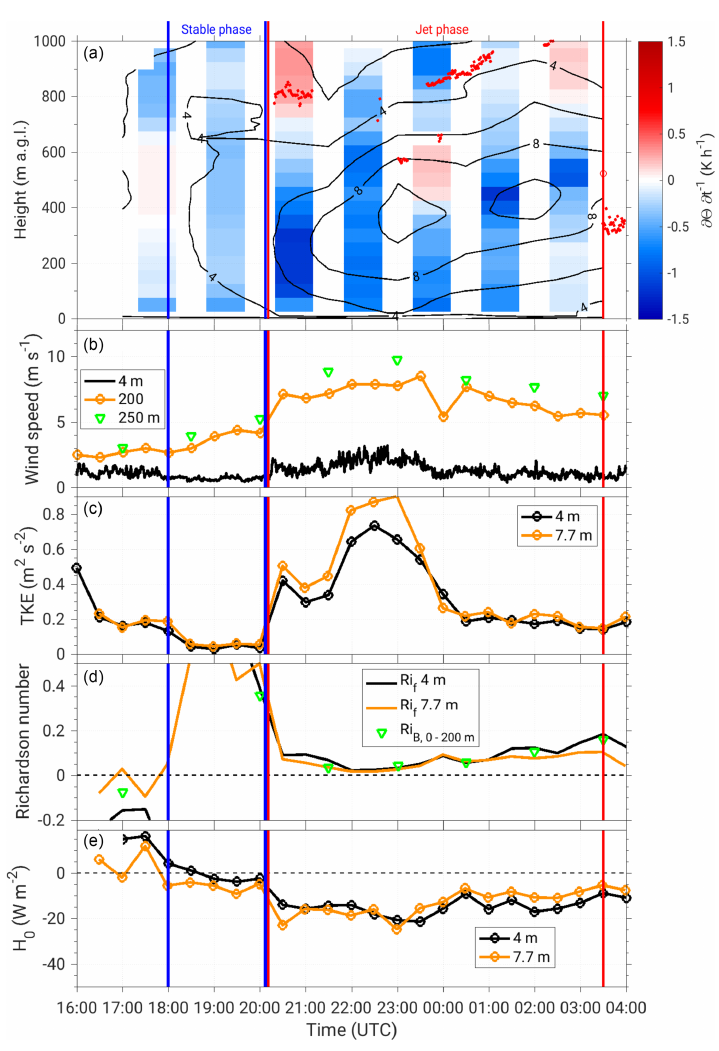
Figure 10. Time–height plot of potential temperature tendency (color coded) and horizontal wind speed (contours) from radiosondes (a) ; time series of horizontal wind speed from near-surface measurements at 4ma.g.l., Doppler lidar at 200ma.g.l. and radiosondes at 250ma.g.l. (b) ; turbulent kinetic energy, TKE (c) ; flux-Richardson number, Ri f , and bulk-Richardson number between the surface and 200ma.g.l., Ri B , 0 − 200m (d) ; and surface sensible heat flux, H 0 (e) for IOP 15. TKE, Ri f and H 0 are measured at 4 and 7.7ma.g.l. Blue and red vertical lines indicate the stable phase and jet phase, respectively. In (a) , each bar represents a potential temperature profile calculated and centered between consecutive